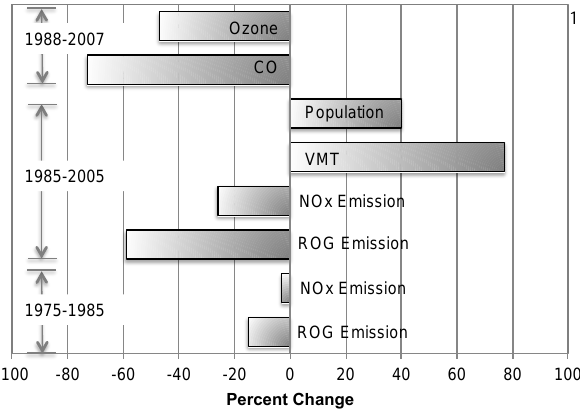
Fig. 15. ROG emissions by sectors in California. 2